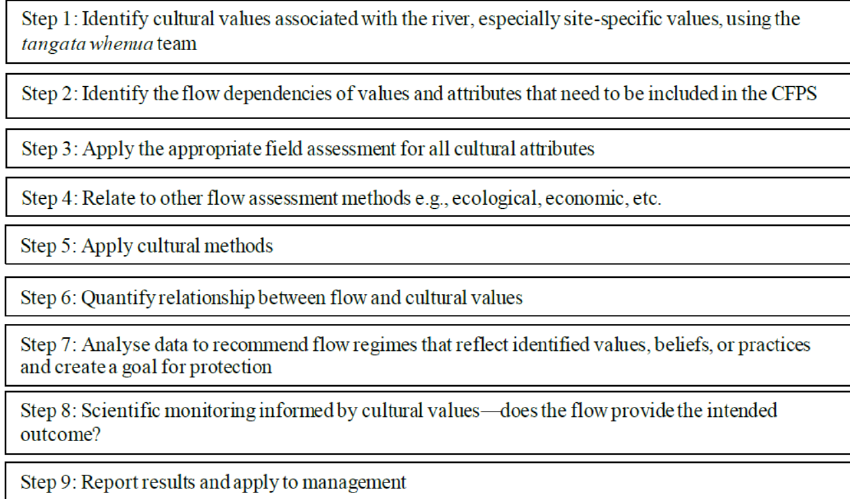
Figure 6. Steps to complete a CFPS. Modified from Crow et al. (2018).